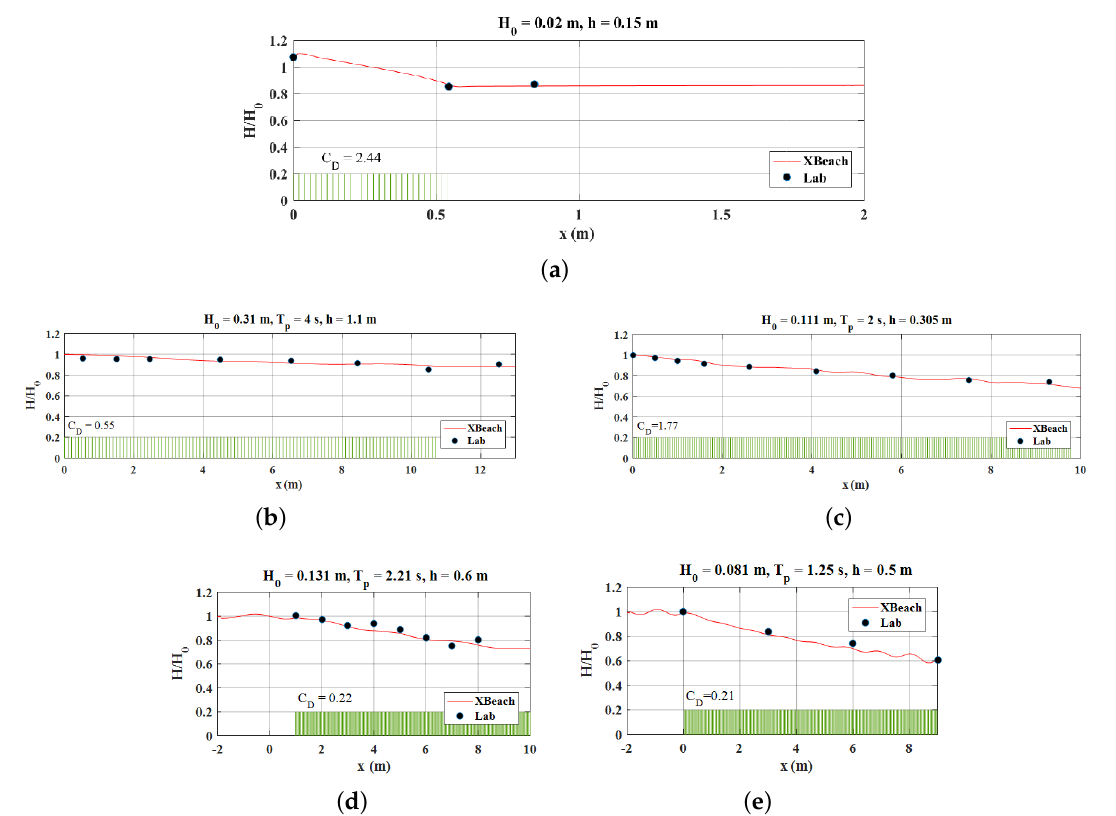
Figure 8. Examples of the normalized wave height across the model vegetation for the experiments listed in Table 1. ( a ) Huang et al. [29]. ( b ) Koftis et al. [30]. ( c ) Anderson et al. [32]. ( d ) Dubi and Tørum [31]. ( e ) Sánchez-González, Sánchez-Rojas and Memos [33]. Symbol: measurements. Line: numerical results. Vertical bars at the bottom are plotted to indicate the location of the vegetation patch and do not reflect the real stem